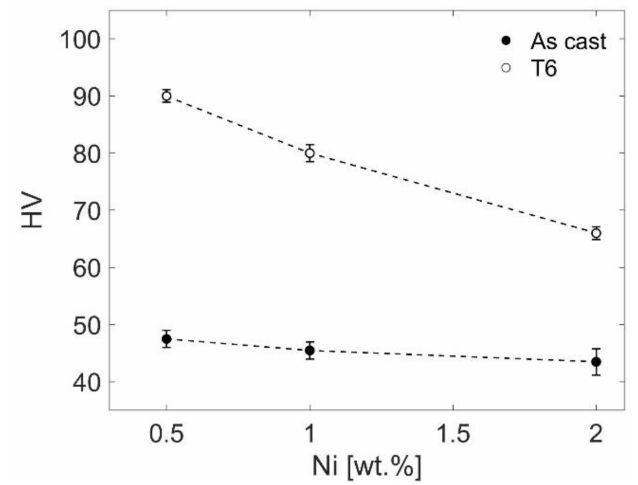
Figure 2. Vickers microhardness, with a normal load of 0.1 N, for as-cast and T6 heat-treated